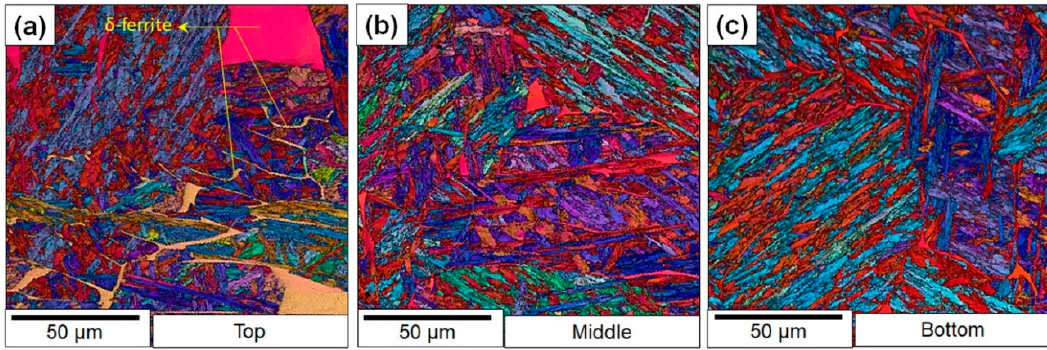
Figure 7. Electron backscatter diffraction (EBSD) micrographs of as-printed samples sectioned from different locations on the wall: ( a ) top; ( b ) middle; ( c ) bottom.